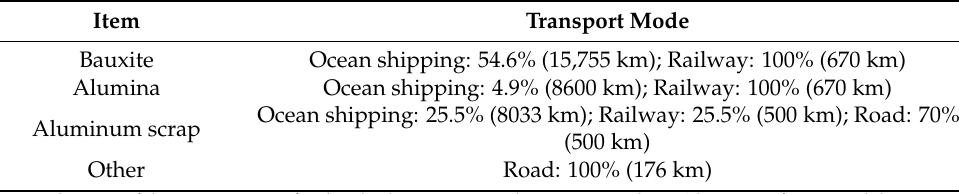
Table 1. Transportation parameters of the aluminum industry in China in 2020 [1,3,34,35].